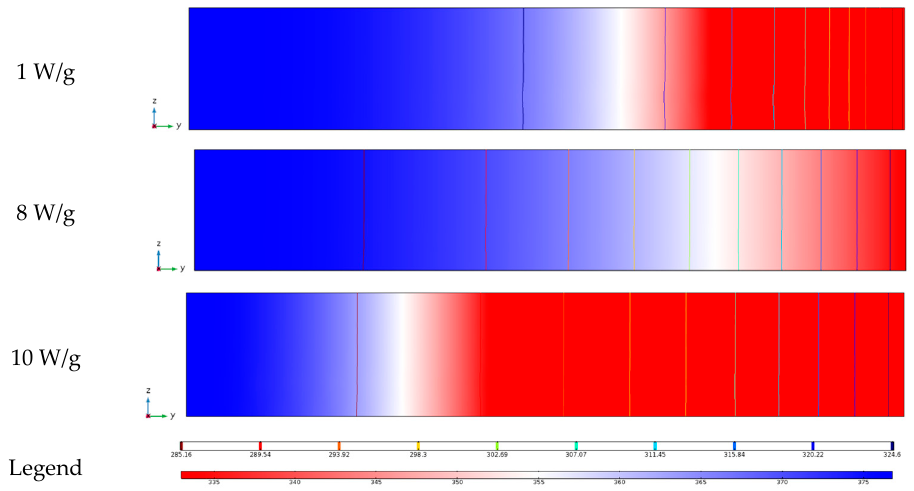
Figure 16. The distribution of the anthocyanin content and contours in the berry puree under different microwave intensities.